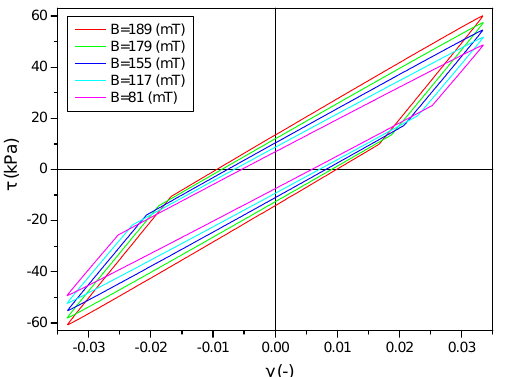
Figure 10. Set of hysteresis loops obtained from the model for subsequently incrementing values of magnetic